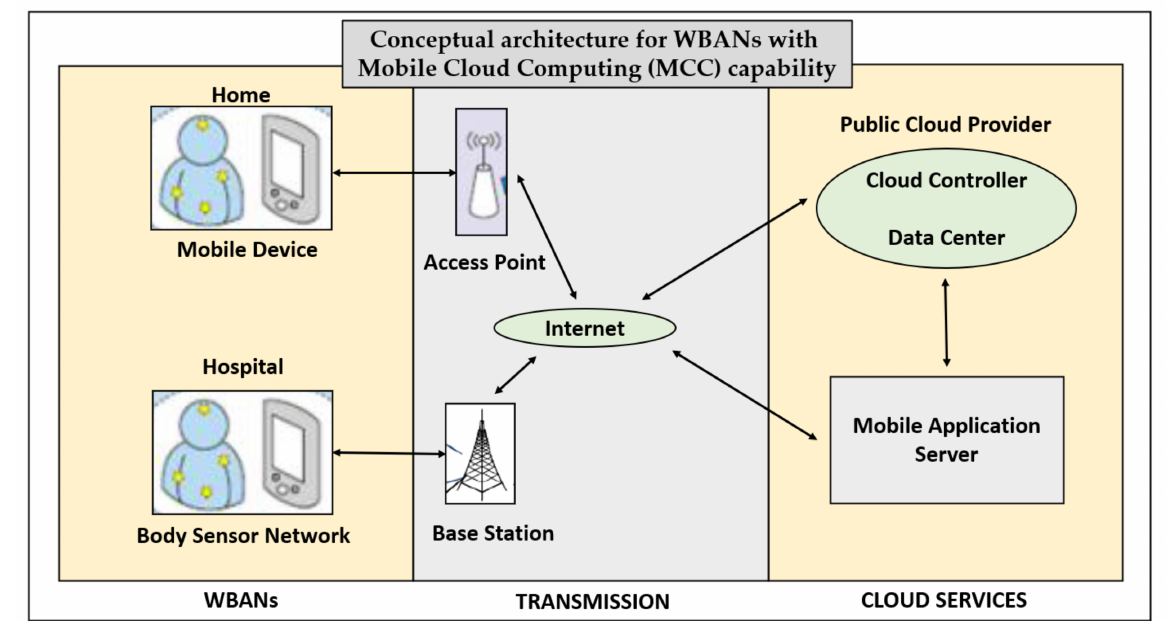
Figure 7. Conceptual architecture for WBANs with MCC